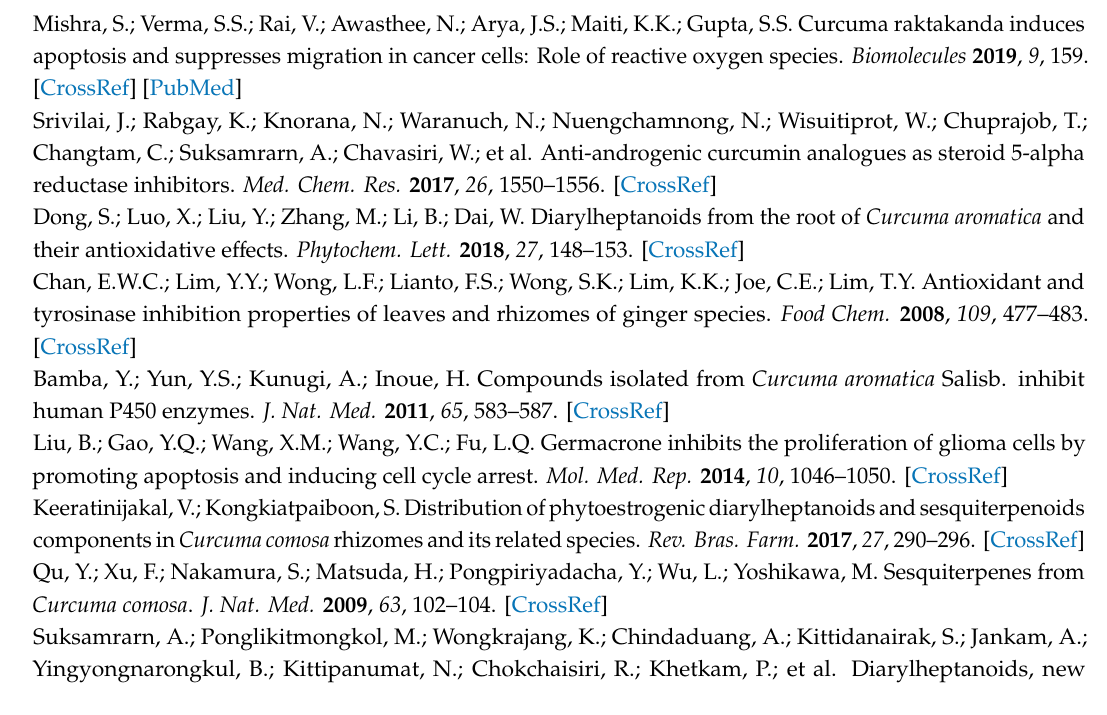
Figure S1: UPLC-HRMS chromatograms of four Curcuma